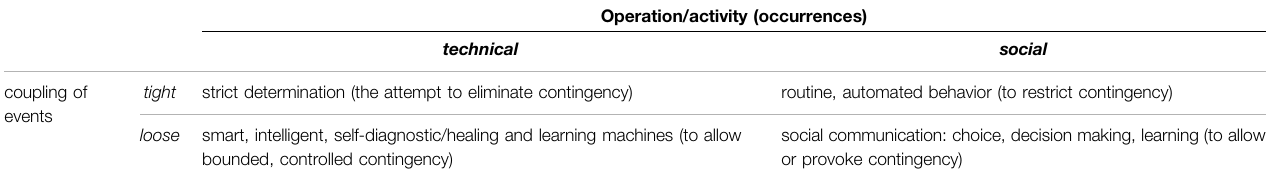
TABLE 1 | Tight and loose couplings in sociotechnical